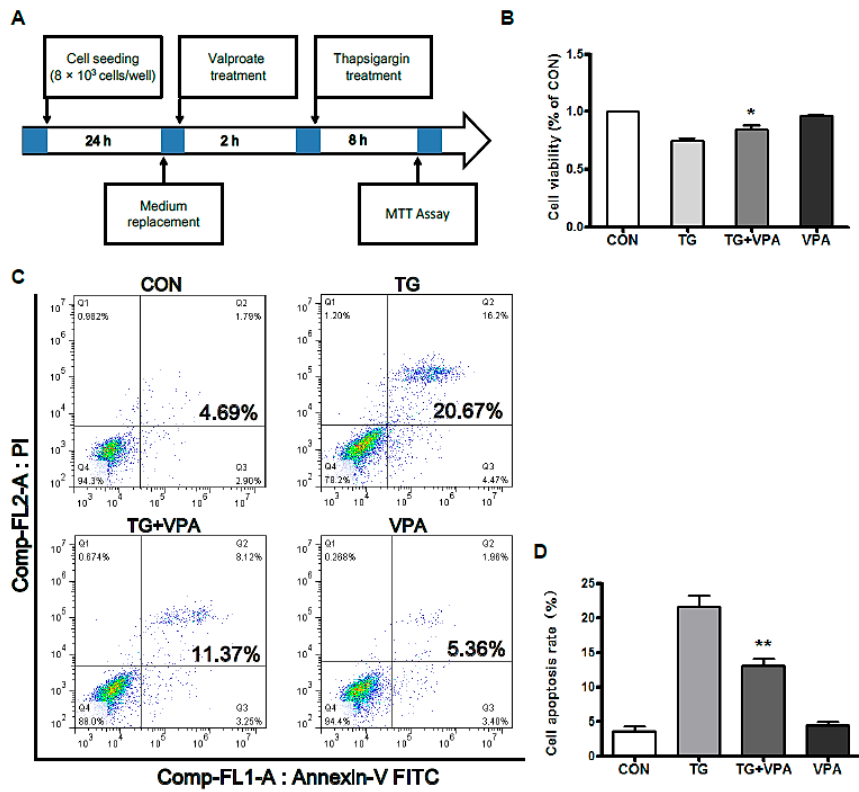
Figure 1. Valproate (VPA) reduces thapsigargin (TG)-induced apoptosis in SH-SY5Y cells. ( A ) The protocol of cell viability assay performed in this study. Cells were divided into four groups: the control group; the TG group; the TG and VPA group; the VPA group; ( B ) MTT assay result of VPA-treated SH-SY5Y cells exposed to TG. * p < 0.05 versus the TG group, n = 6; ( C ) Induction of apoptosis in human SH-SY5Y cells was determined by flow cytometry after treatment with TG, TG and VPA, and VPA; ( D ) The percentage of apoptotic cells in the treatment groups was calculated, ** p < 0.01 versus the control group, n = 3.